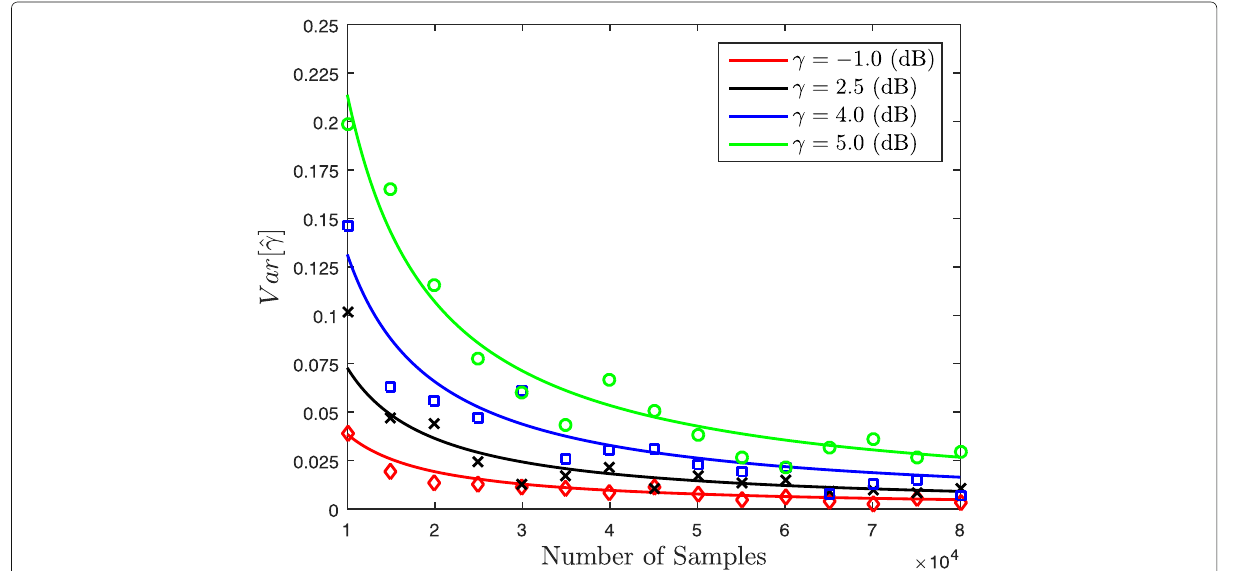
Fig. 6 Variance of the estimate ˆ γ as a function of the number of samples N for different values of SNR γ and 64-QAM modulation considering η − μ fading with η = 0.1 and μ =